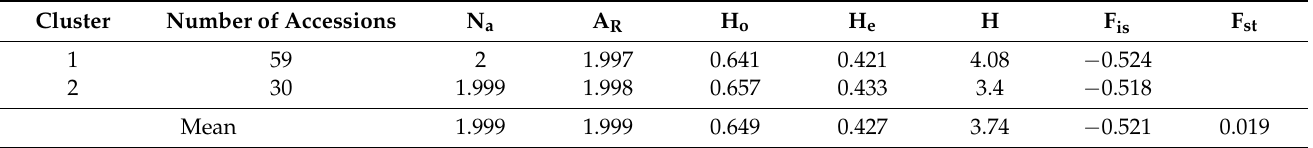
Table 3. Genetic diversity indices based on 5922 SNPs among two clusters of tarwi .